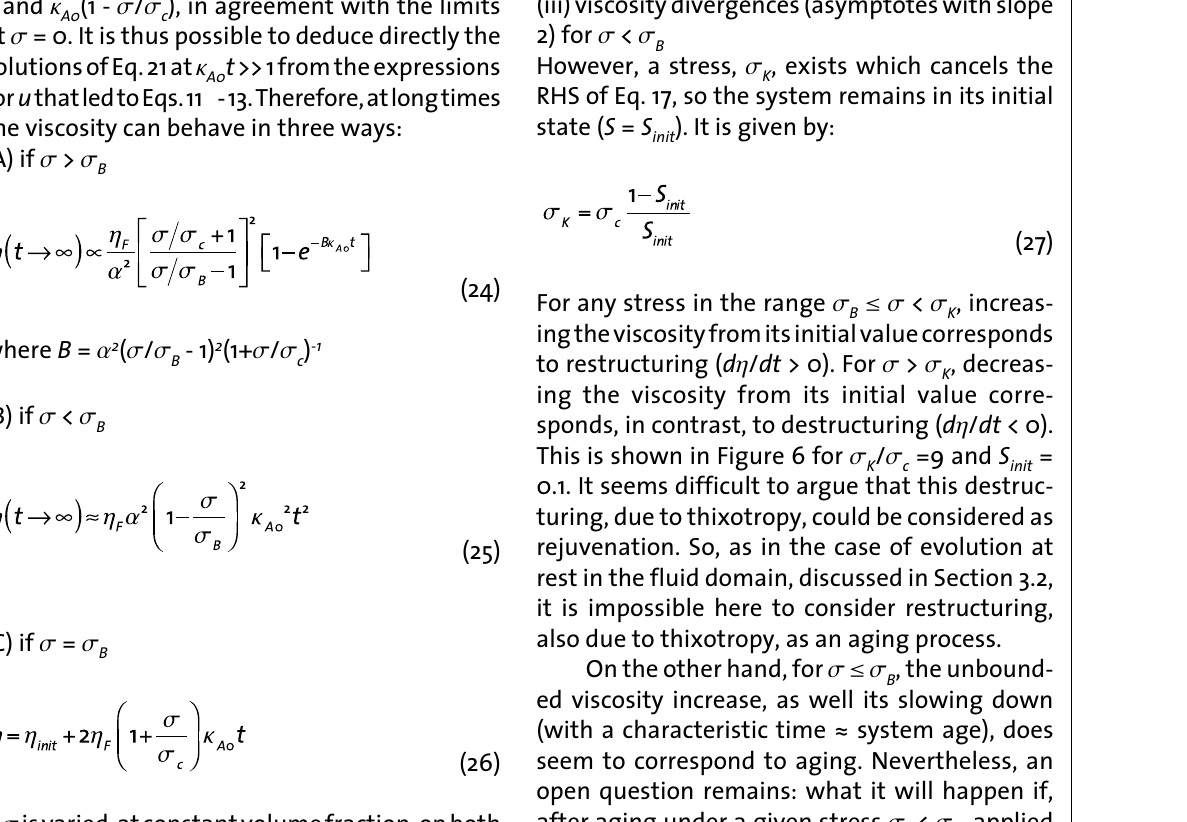
Figure 5 (left): Relative viscosity versus reduced time t = k t. The R A0 bifurcation is observed at s = s as the reduced stress B s / s is varied. Reduced c stress values: 0.1, 0.3, 0.36, 0.371, 0.38, 0.4, 0.5, 1, 2, 10, 50, 100 (from top to bot- tom). (Model parameters: f = 0.45, f = 1 mPa·s, F s = 10 Pa, j = 0.637, c S = 0.1, k = 10 3 s -1 ). init A0 Figure 6: Idem Figure 5 but at high stresses. “Rejuvenation” is observed for s > s = 9 R RK (see text, for parameter val- ues see Figure